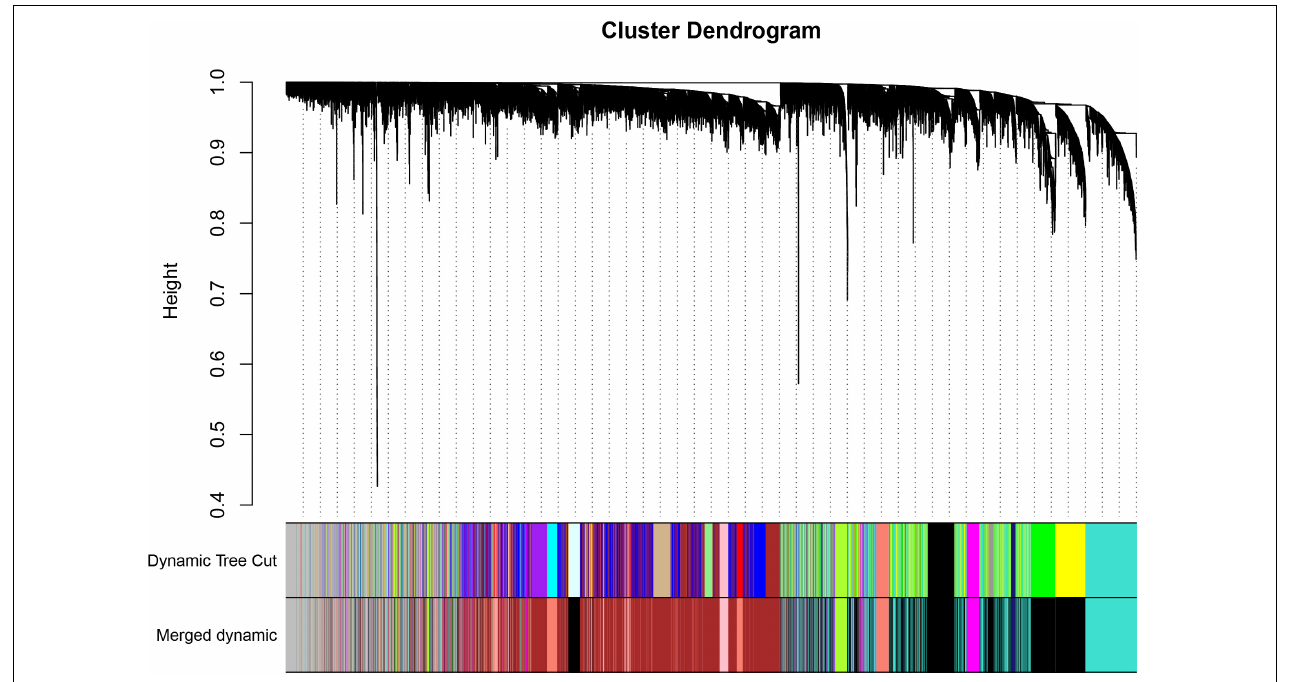
FIGURE 1 | Clustering dendrogram of genes with dissimilarity based on topological overlap, together with assigned module colors.